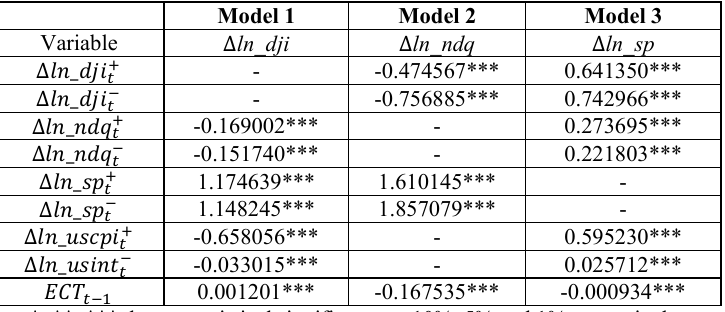
Table 2. Estimation results of the short-run models.